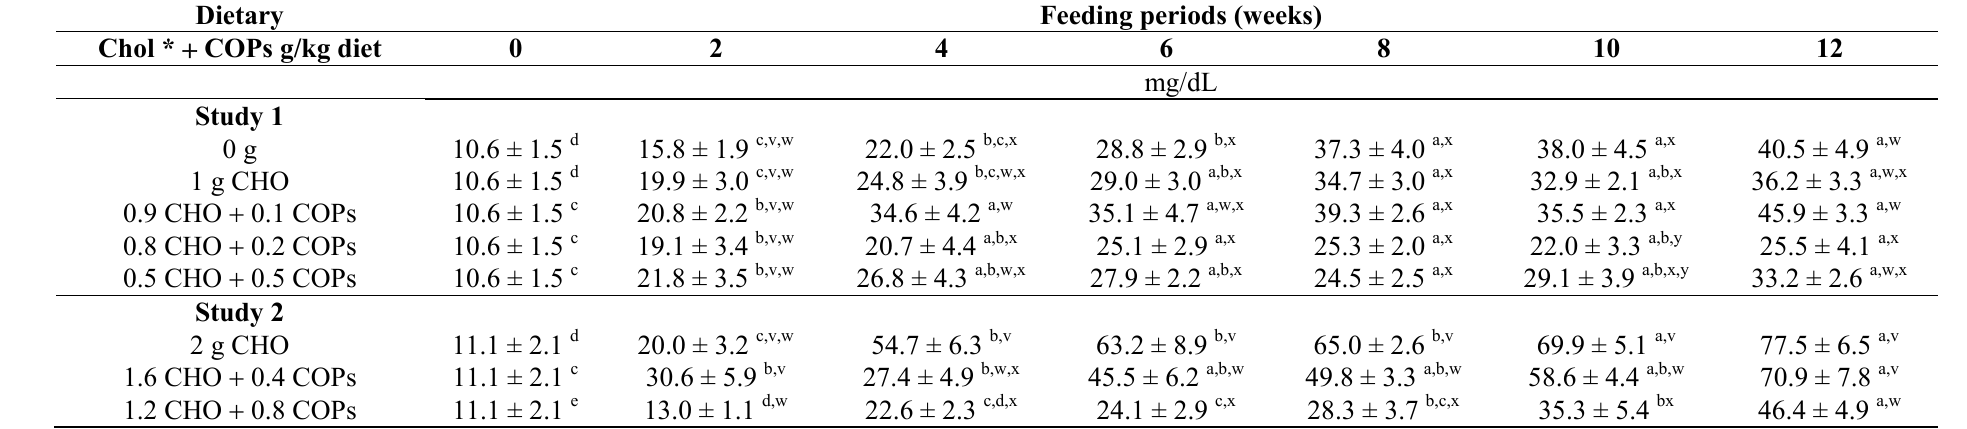
Table 3. Effect of dietary cholesterol and cholesterol oxides on triglyceride content in serum. Dietary Feeding periods